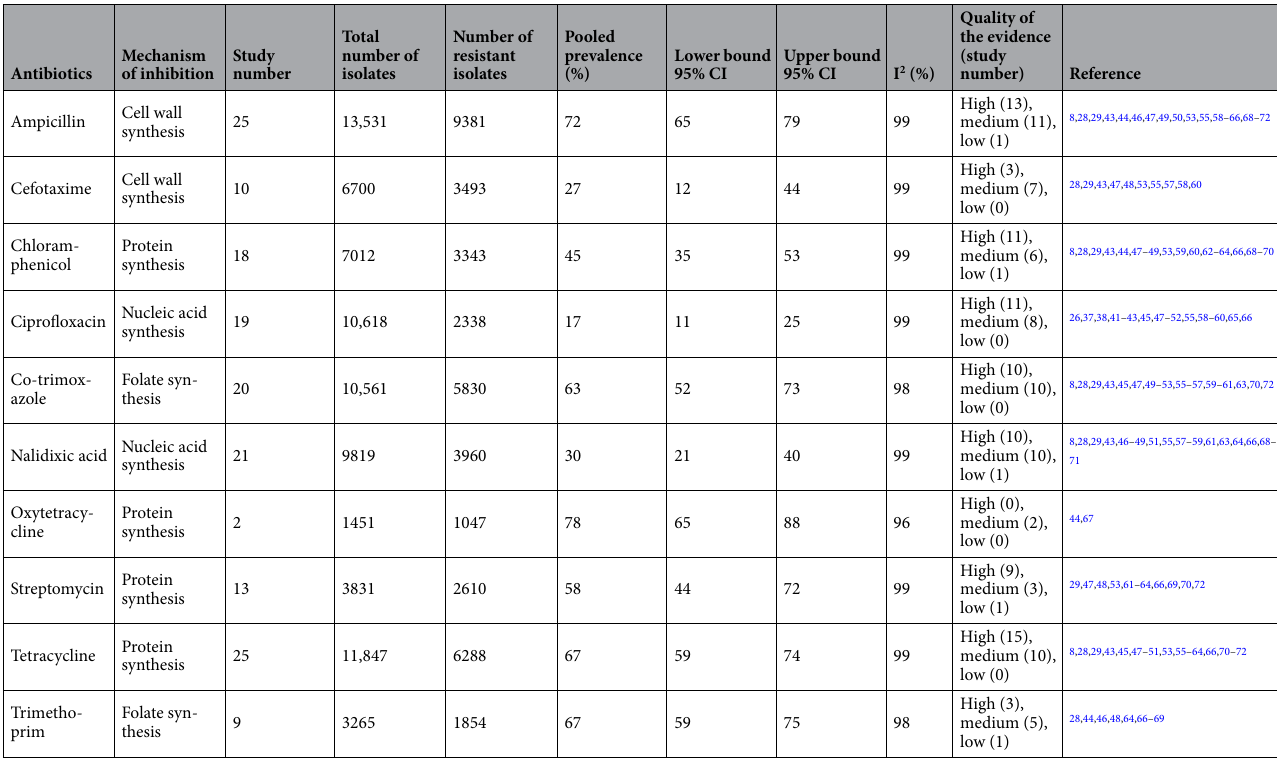
Table 1. Prevalence of antibiotic resistance in commensal E. coli isolated from human sources in community settings in low- and middle-income